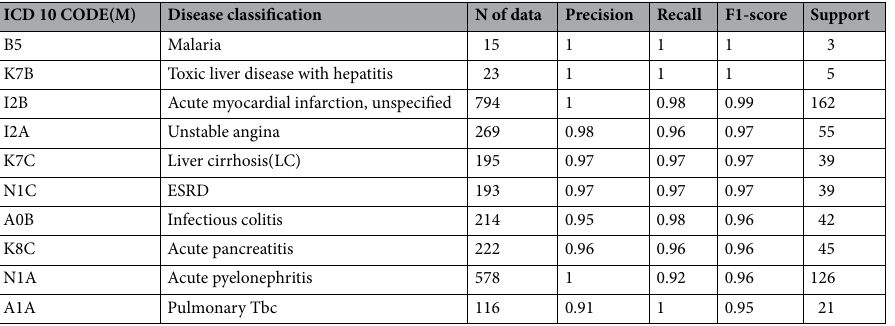
Table 3. Ensemble model TOP 10 result using accuracy performance measure. M modified.